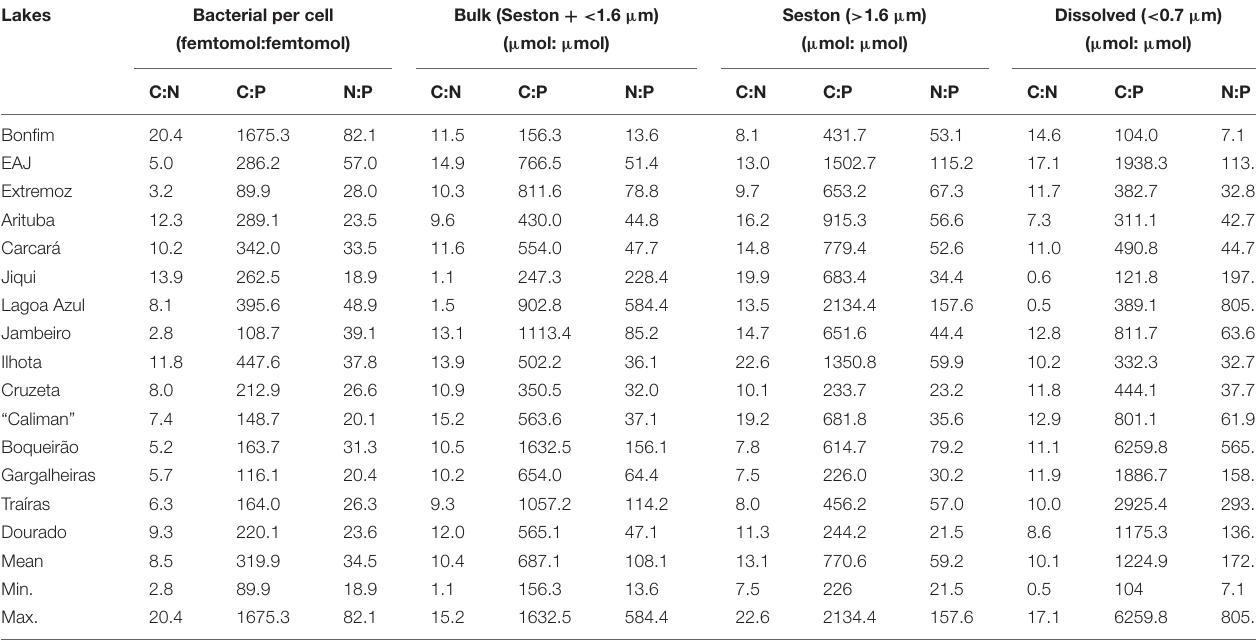
TABLE 2 | Molar ratios of carbon (C), nitrogen (N) and phosphorus (P) for bacteria and the three substrates fractions (bulk, seston and dissolved) for the 15 lakes along a trophic gradient. Lakes Bacterial per cell Bulk (Seston + < 1.6 µ m)